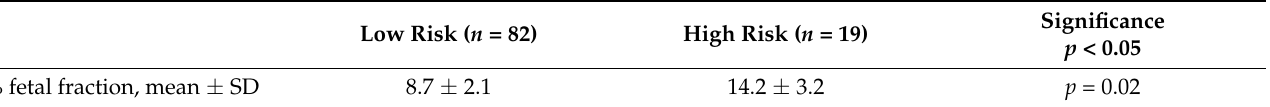
Table 8. Percentage of fetal DNA fraction in the study sample. Low Risk ( n = 82) High Risk ( n = 19)